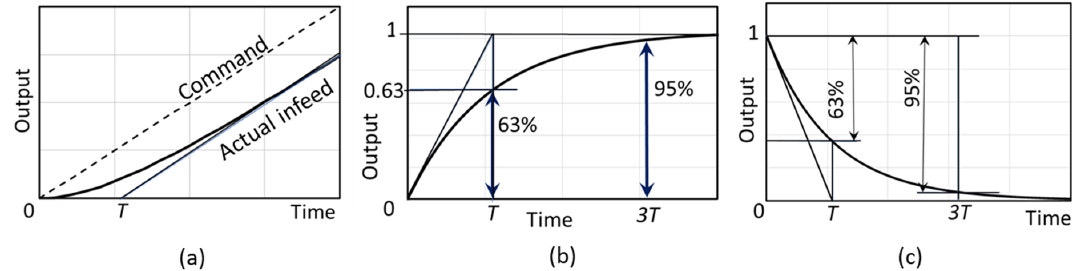
Figure 11. Effect of time constant on infeed grinding processes. ( a ) Slide position; ( b ) Forces, power and machine deflection; ( c ) Spark-out in forces, power and deflection.